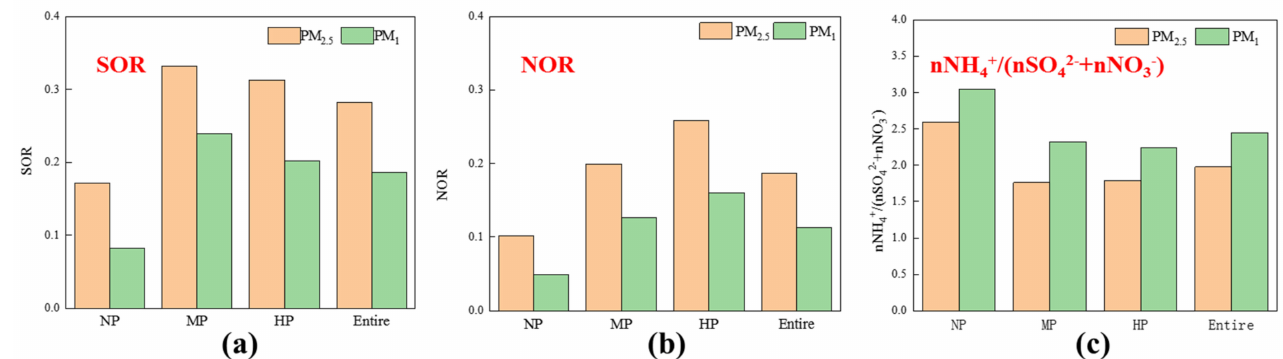
Figure 3. NOR ( a ), SOR ( b ), nNH 4+ /(nNO 3 − + nSO 42 − ) ( c ) in PM 1 and PM 1–2.5 on non-pollution, mild-moderate pollution and heavy pollution in Handan during the investigation period.